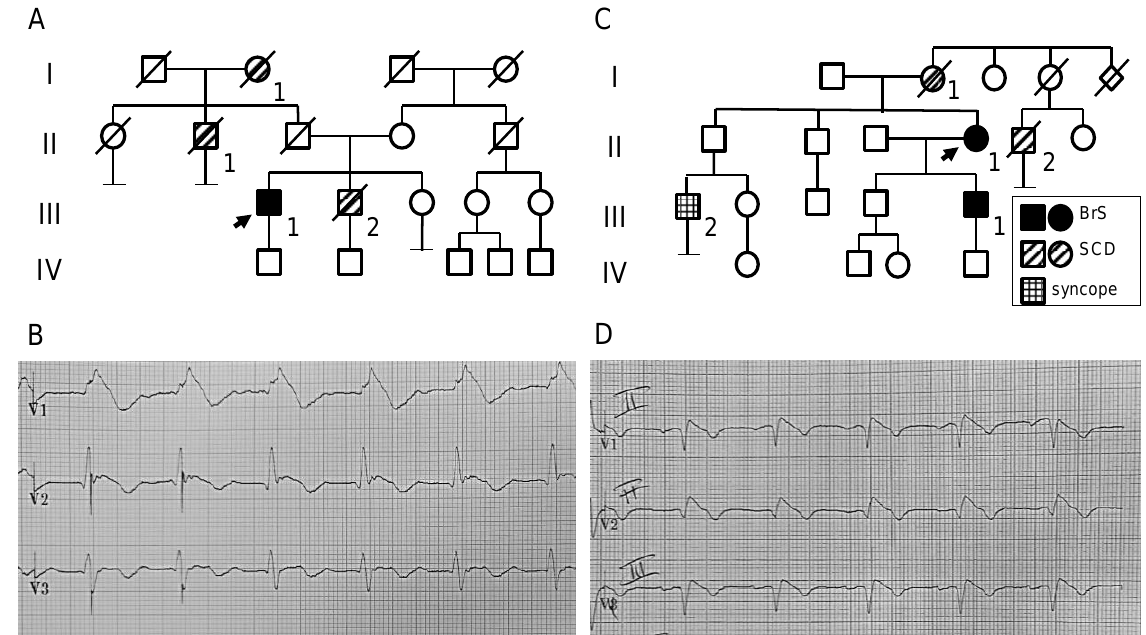
Figure 1. Pedigree and ECG of the BrS families. ( A ) Pedigree of family of patient I (III-1) carrying the missense variation c.3929C>T (Pro1310Leu) in SCN5A . The genetic analysis was performed only in proband’s son who resulted negative for the Pro1310Leu variation. I-1: SCD at 87 years; II-1: SCD at 78 years; III-2: SCD at 51 years. ( B ) ECG of patient I shows Brugada type 1 pattern in V1-V2 recorded at standard intercostal space. ( C ) Pedigree of family of patient II (II-1) carrying Gly1687_Ile1688insGlyArg in heterozygosis in SCN5A . Her son (III-1) carries both the maternal variation and the His558Arg benign polymorphism in SCN5A . The Ins1687GR insertion was searched exclusively in the two subjects manifesting symptoms and/or BrS ECG pattern, in light of the uncertain significance of the variation. I-1: SCD at 38 years; II-2: SCD at 50 years; III-2: syncope and negative drug-induced testing for BrS. ( D ) ECG of patient II shows Brugada type 1 pattern in V1-V2 recorded at second intercostal